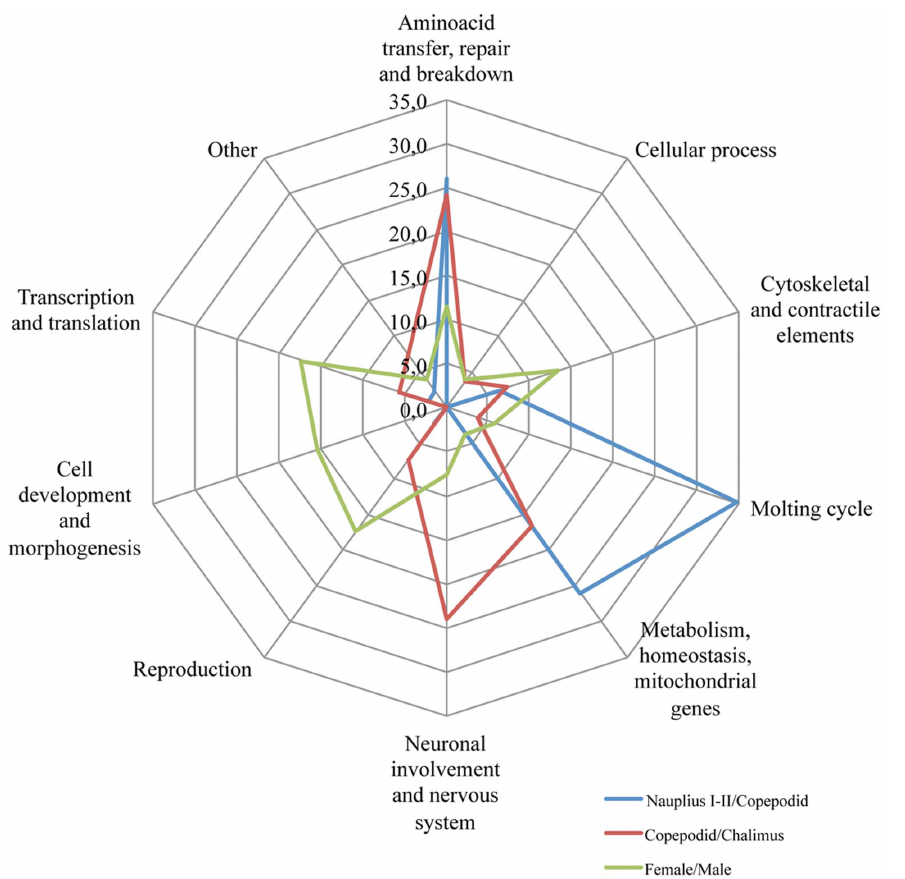
Figure 7. Radar plot of contigs with significant expression values (P # 10–16; |fold-change| . 5) in terms of percentages for nauplius I–II/copepodid, copepodid/chalimus and female/male from C.rogercresseyi . Annotated contigs were associated to (i) aminoacid transfer, repair and breakdown, (ii) cellular process, (iii) cytoskeletal and contractile elements, (iv) molting cycle, (v) metabolism, homeostasis, mitochondrial genes, (vi) neuronal involvement and nervous system, (vii) reproduction, (viii) cell development and morphogenesis, (ix) Transcription and translation and (x) others.